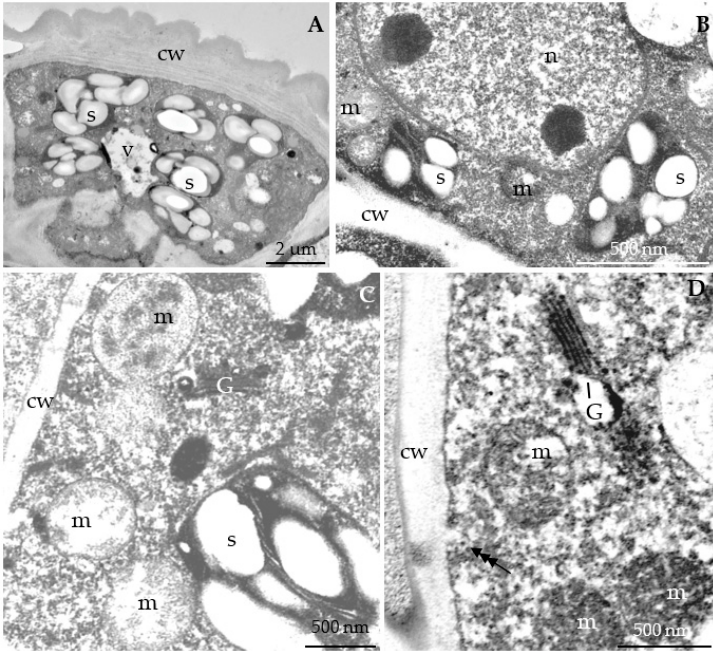
Figure 13. ( A – D ). Fragments of epidermis ( A , C ) and nectary parenchyma ( B , D ) cells in R. idaeus ‘Laszka’ in the initial secretion phase. ( A ): outer cell wall (cw) with prominent protuberances, starch grains (s) in plastids, vacuole (v). ( B ): cell nucleus (n) with two nucleoli, amyloplasts filled with starch grains (s), mitochondria (m), cell wall (cw). ( C , D ): Golgi apparatus (G), mitochondria (m) near the cell wall (cw), starch grains (s) (micrograph C), vesicle fused with the plasmalemma (three-headed arrow) (micrograph D).